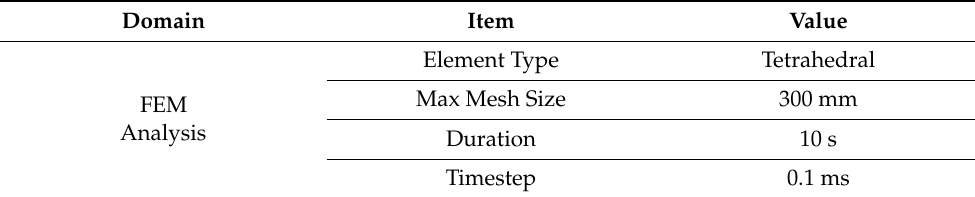
Table 2. FEM model and analysis